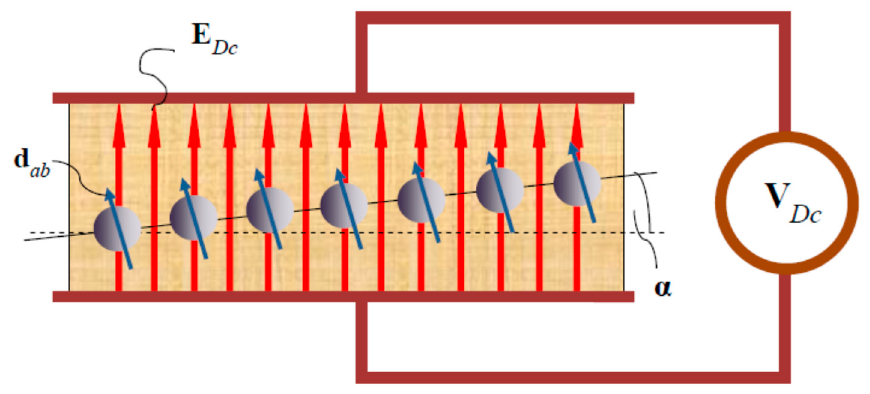
Figure 18. General illustration of the periodic two-level atomic chain used as a model, indicating Stark effect in the ultrastrong coupling regime. The chain is placed obliquely between the armatures of plane capacitor with applied dc voltage. The dipole moments (blue arrowheads) are oriented orthogonally to the chain axis. Dc field (red arrowheads) are oriented angularly with respect to the chain axis. The choice of the angle allows for obtaining the arbitrary relative value between Rabi- and Bloch frequencies.